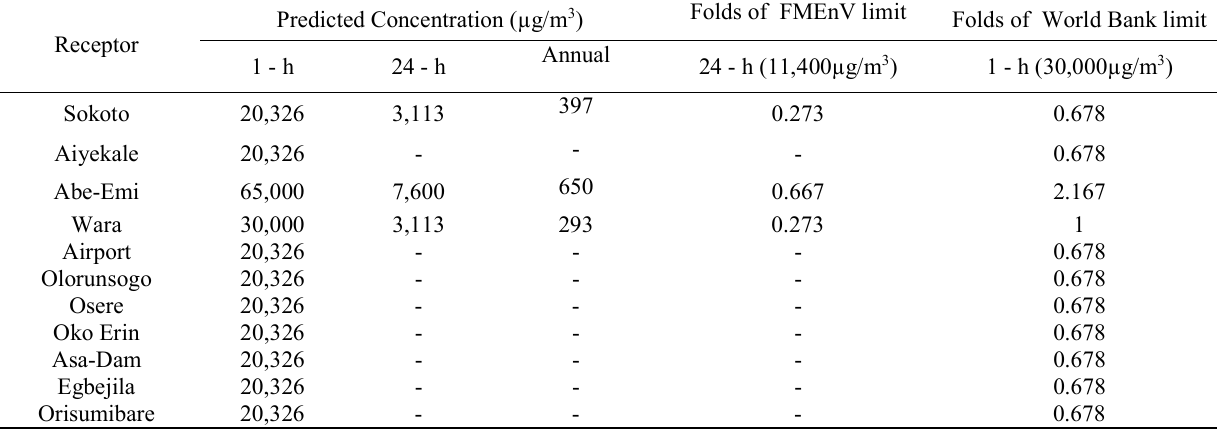
Table 3. Predicted cumulative impacts of CO around Sokoto-Aiyekale dump site.